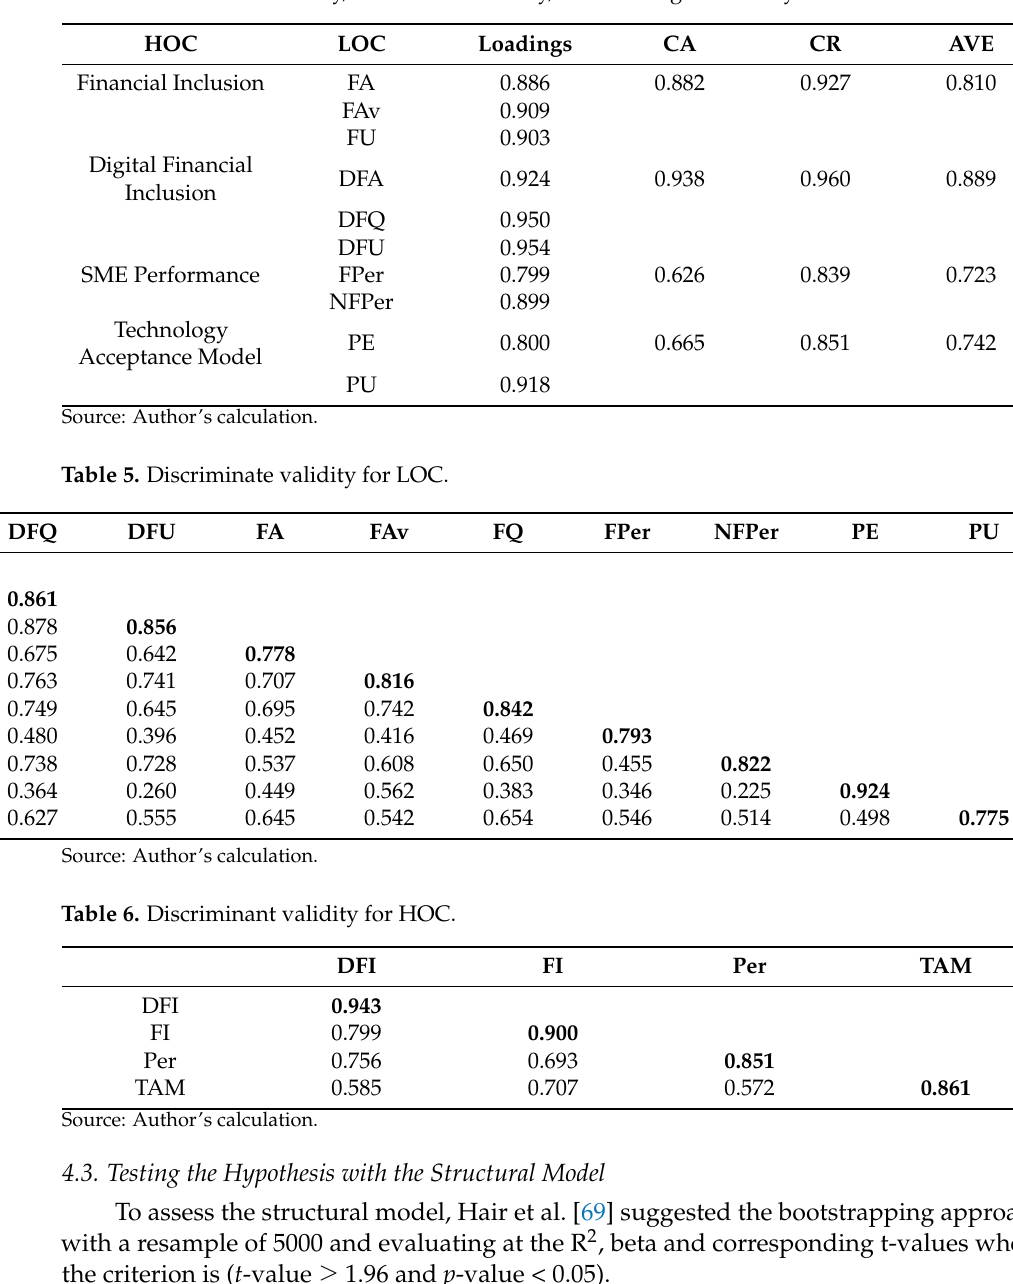
Table 4. Results of reliability, internal consistency, and convergent validity of HOC.